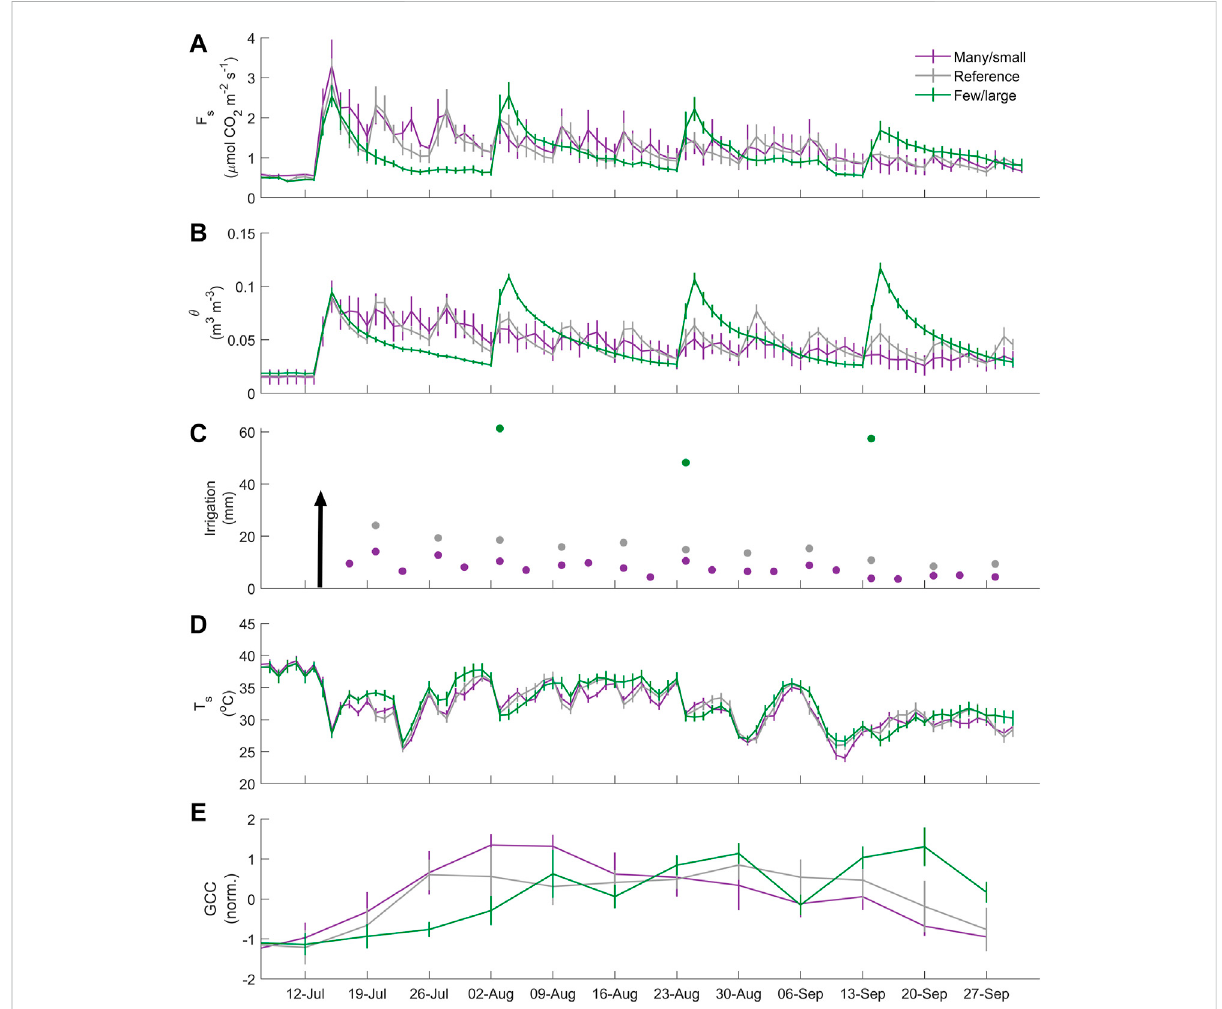
FIGURE 1 Growing season dynamics in (A) daily mean soil CO 2 ef fl ux (F s ), (B) daily mean volumetric soil moisture ( θ ), 0 – 10 cm, (C) irrigation amount, (D) daily mean soil temperature (T s , 0 – 10 cm), and (E) and weekly-average of daily mean green chromatic coordinate (GCC) normalized anomalies under three levels of rainfall repackaging. Arrow denotes uniform 38 mm irrigation event on 14 July. Vertical lines indicate standard